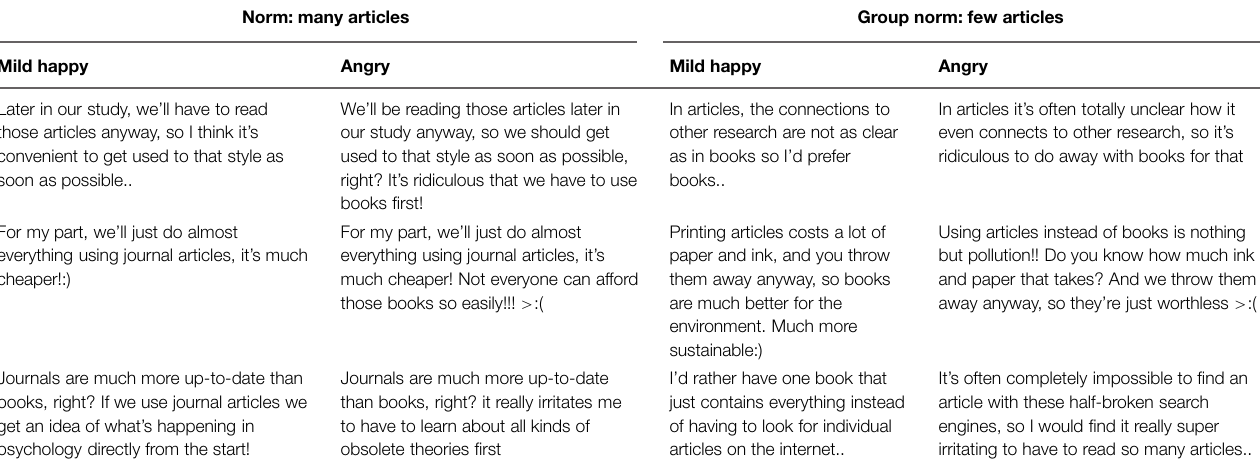
TABLE 4 | Statements sent by the simulated group members during the simulated group interaction (Study 2). Norm: many articles Group norm: few articles Mild happy Angry Mild